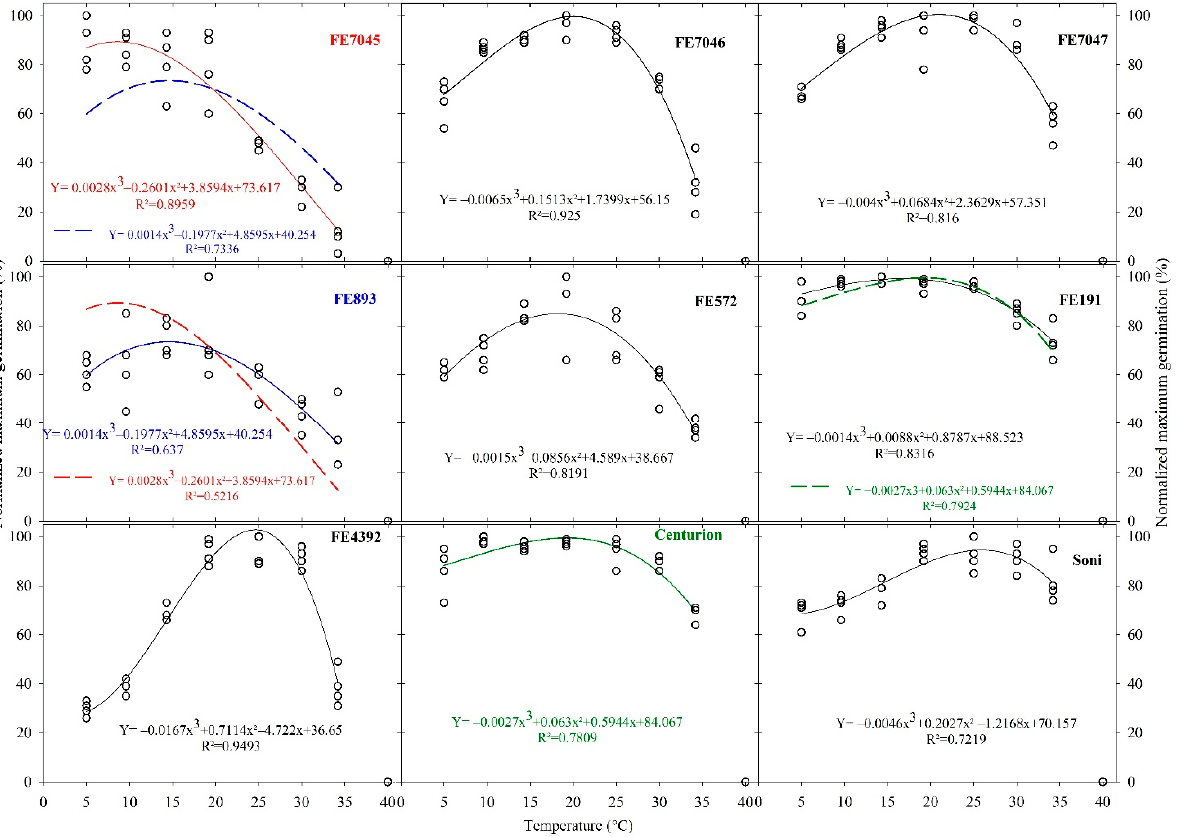
Figure 2. Normalized maximum germinability of nine accessions of F. arundinacea in response to the constant temperature.